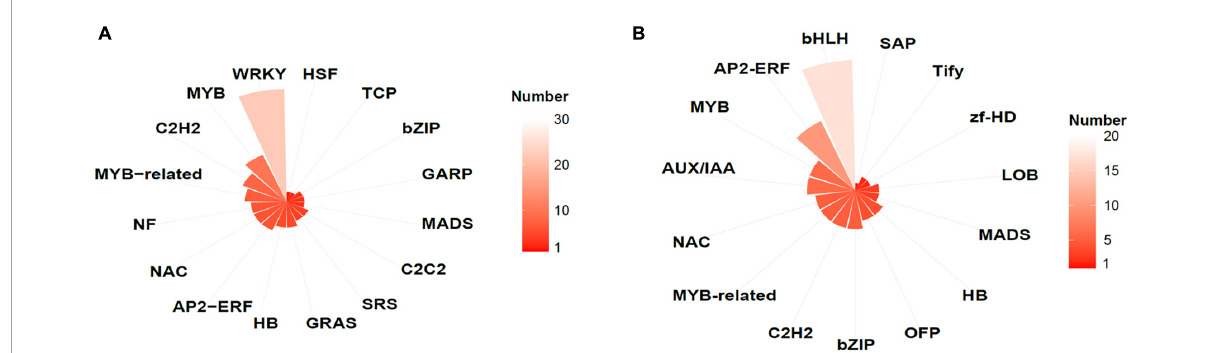
FIGURE5 Transcription factor (TF) families identified in DEGs in EV and AtMYB12 transcriptomes. (A) Upregulated TFs represented by gene numbers (the lighter the color, the higher the number); e.g., the most upregulated TFs belong to WRKY family. (B) Downregulated TFs represented by gene numbers (the lighter the color, the higher the number); e.g., the bHLH family is most